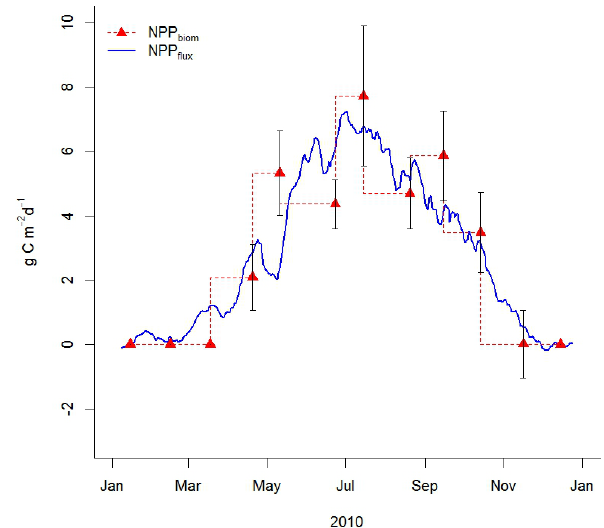
Fig. 6. Annual pattern of NPP (gCm − 2 d − 1 ) . The dashed line represents daily NPP obtained from biometric measurements (NPP biom ) and the solid line represents the 15 days moving av- erage of NPP obtained by summing the daily fluxes of R h and NEP (NPP flux ) . Bars represent standard error (se) of the mean daily NPP biom